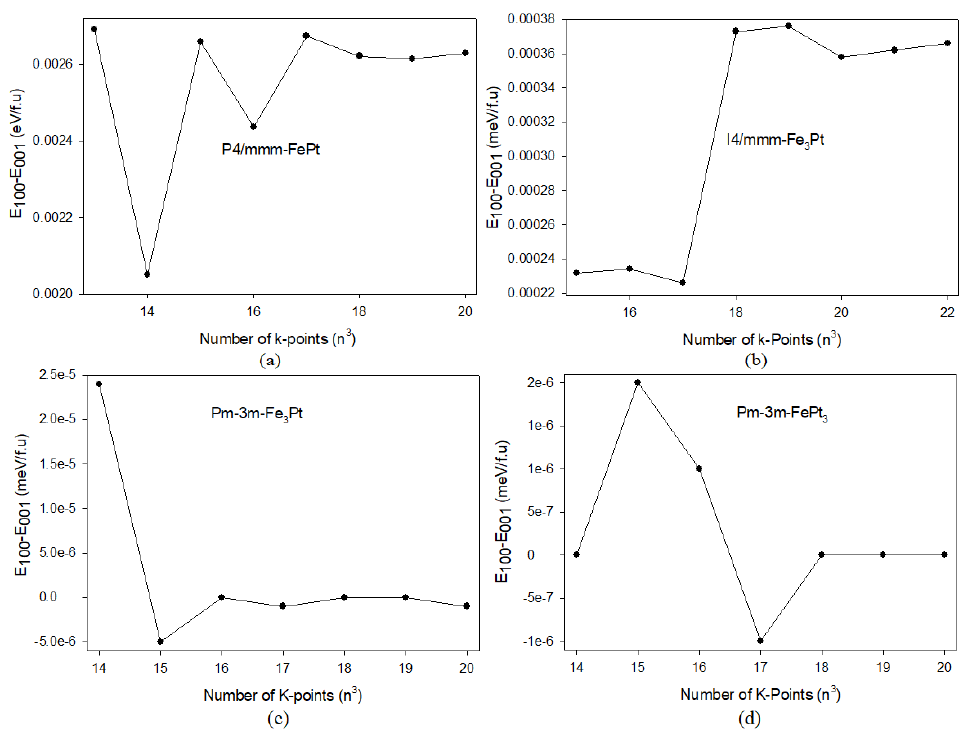
(cid:0) (cid:1) n 3 , n ∈ Z